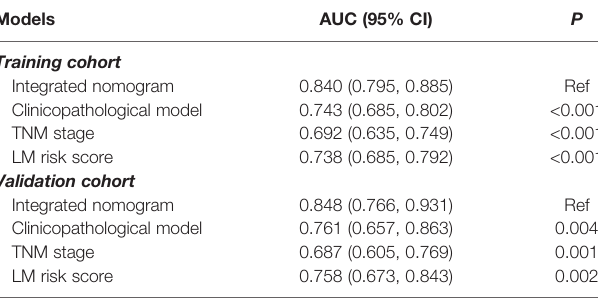
TABLE 4 | ROC comparison of the integrated nomogram with other prediction models at 3 years.